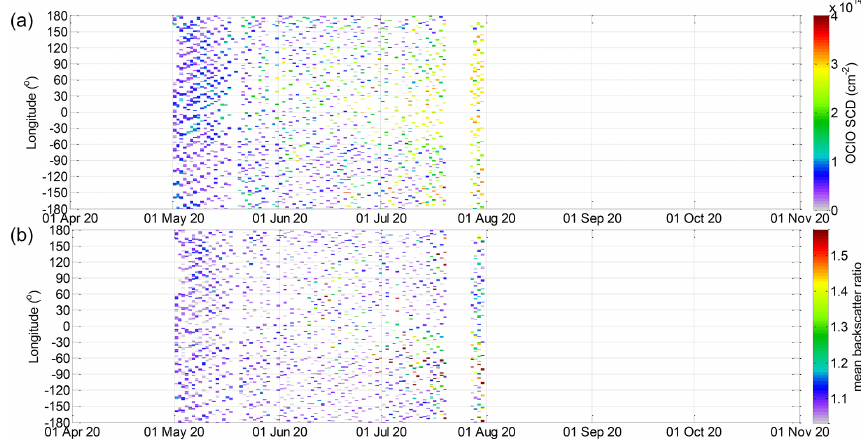
Atmos. Chem. Phys., 22, 245–272, 2022